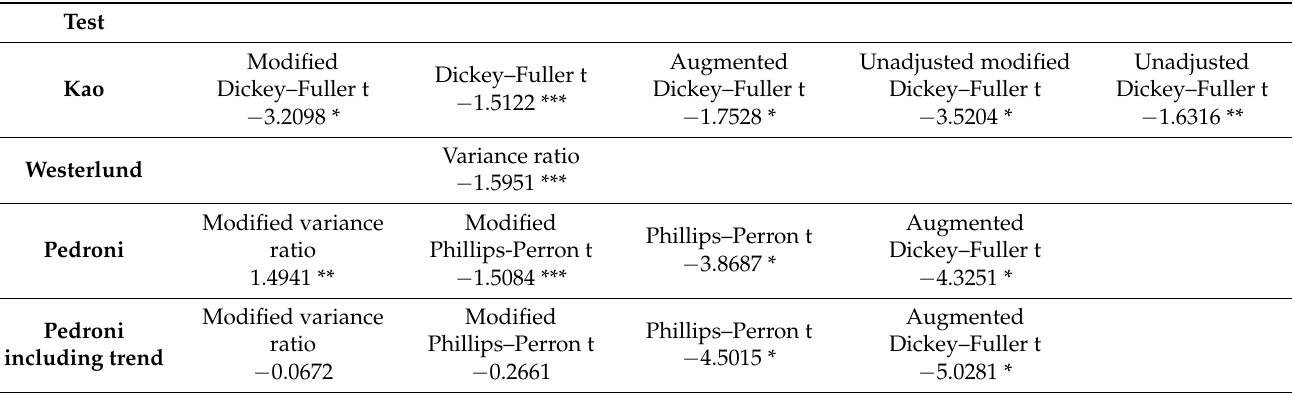
Table 5. Cointegration testing.